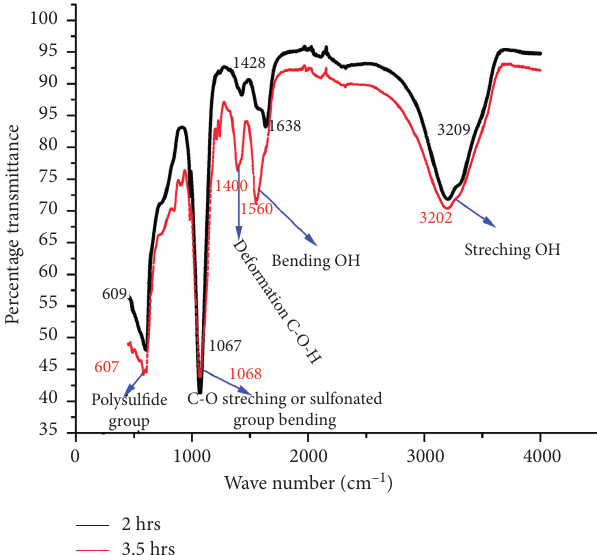
Figure 5: FTIR spectra of cobalt sulfide thin films deposited at 2 and 3.5